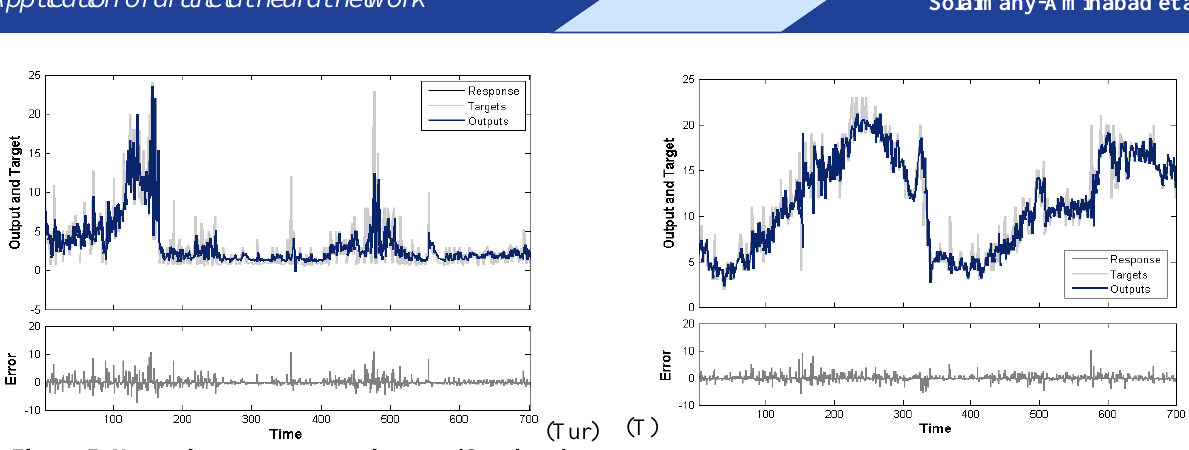
Figure 5. Networks responses and errors (Continue) TH: Total hardness; TDS: Total dissolved solids; Alk: Alkalinity; EC: Electrical conductivity; Tur: Turbidity; T: